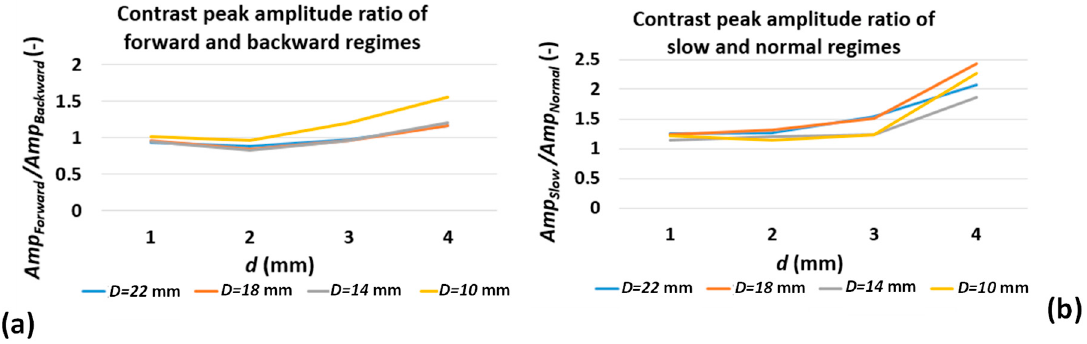
Figure 9. Contrast peak amplitude ratio of ( a ) various test direction and ( b ) various test speed regimes for various defect diameters and depths.